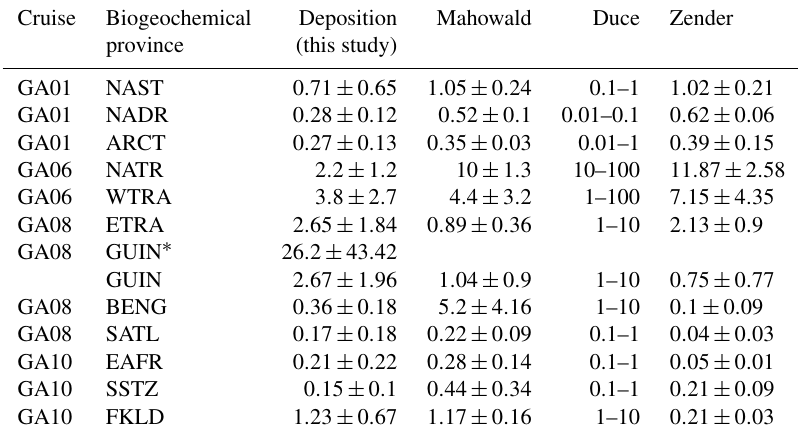
Table 2. Average atmospheric deposition fluxes estimated for each biogeochemical province. For reference on the different regions please refer to Table S1. The deposition fluxes are given in gm − 2 yr − 1 . Mahowald, Duce, and Zender refer to the atmospheric deposition flux results provided in Mahowald et al. (2005), Duce et al. (1991), and Zender et al. (2003), respectively. GUIN ∗ refers to deposition results affected by additional Al inputs from the Congo River